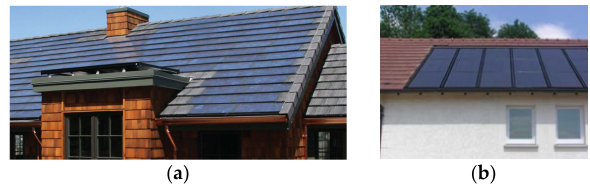
Figure 1. Examples of BIPV tiles ( a ) and BIPV modules ( b ) (Applied Solar [4], DuPont [5]).